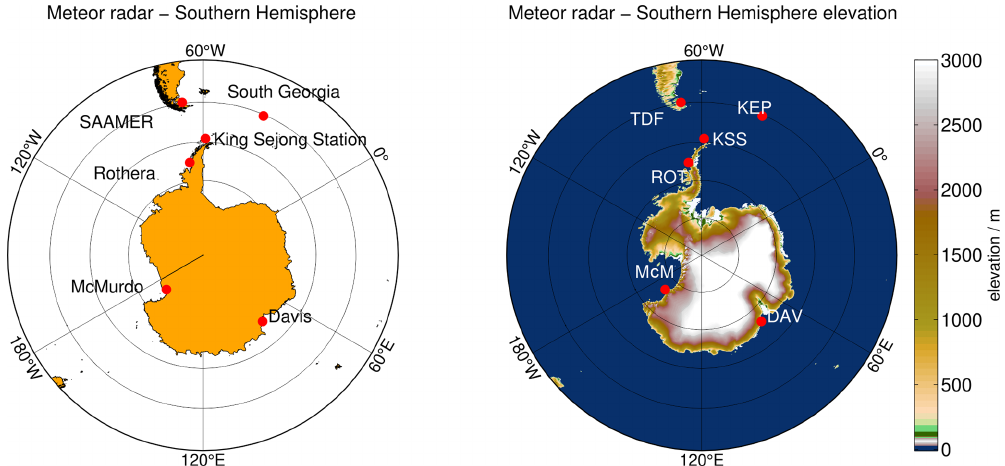
Figure 1. Stereographic projection of the geographic location of the meteor radars used in this study and a map of the terrain elevation of Antarctica, the Antarctic Peninsula, and southern Argentina to visualize the orography around each radar station. The maps are generated using etopo1 data (Amante and Eakins, 2009). Table 1. Technical parameters of the meteor radars. TDF KEP KSS ROT DAV McM Tierra del King Edward King Sejong Rothera Davis McMurdo Fuego Point Station Freq. (MHz)